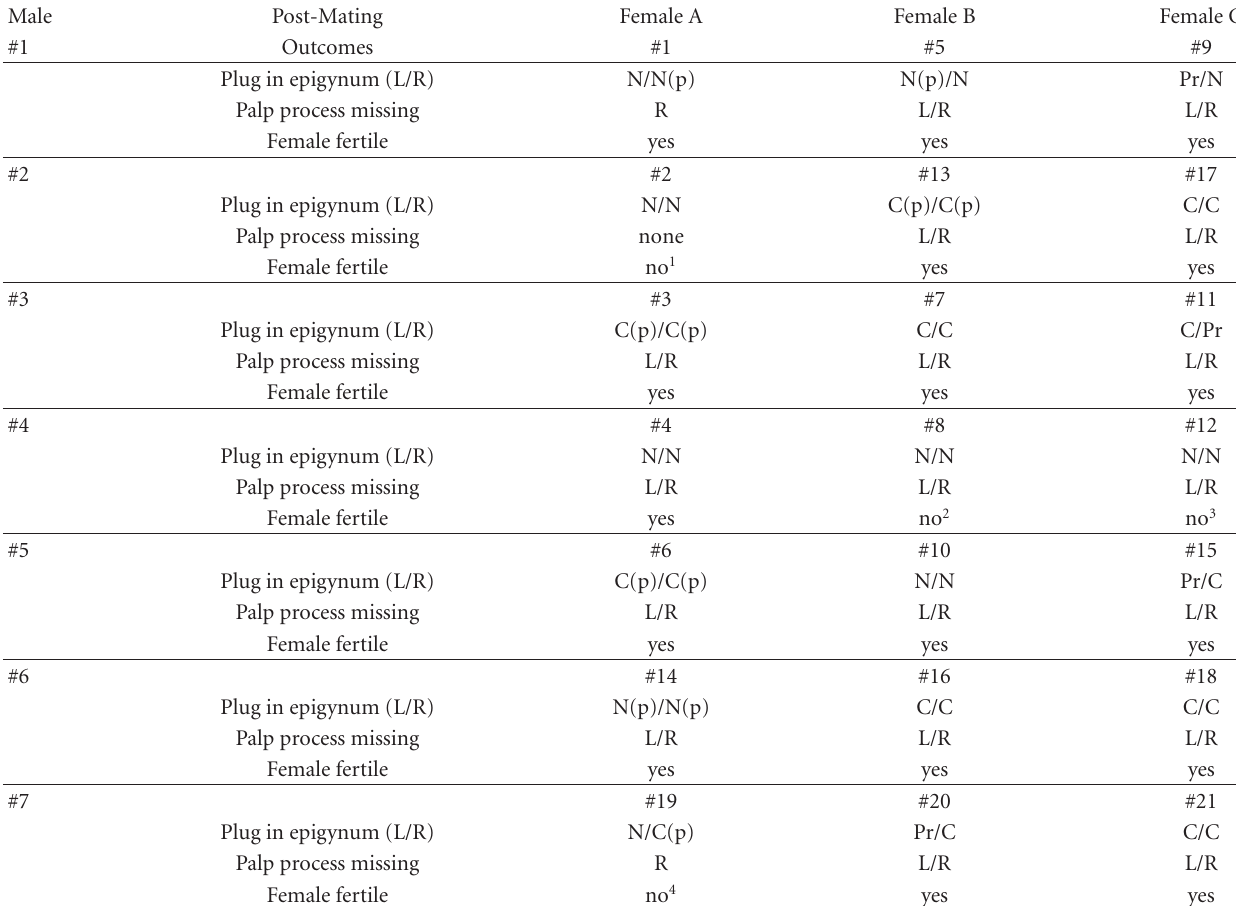
Table 1: Mating trial results for male Peucetia viridans with consecutive female partners (A, B, C). Postmating condition of pairs is as follows: For Females : plug in epigynum (left: L, right: R, orifices): C, complete; Pr: partial; N: absent (male paracymbial processes (p) are noted when present); female fertile ( = live young from resulting egg sac(s)), yes or no; For Males : palp (paracymbial) process missing, left (L), right (R) palp. Source and identification numbers of spiders are given in the